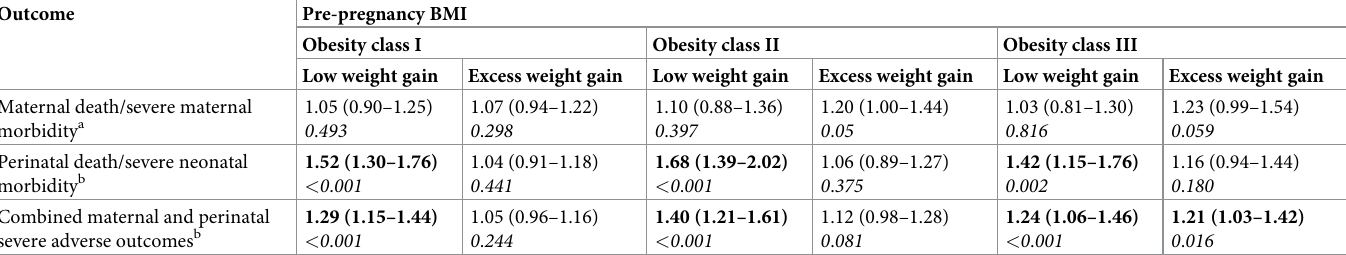
Table 4. Adjusted odds ratios (AORs) for severe adverse outcomes by gestational weight gain and obesity class—Singleton births, Washington State, 2004–2013 (AOR relative to optimal weight gain in each obesity class